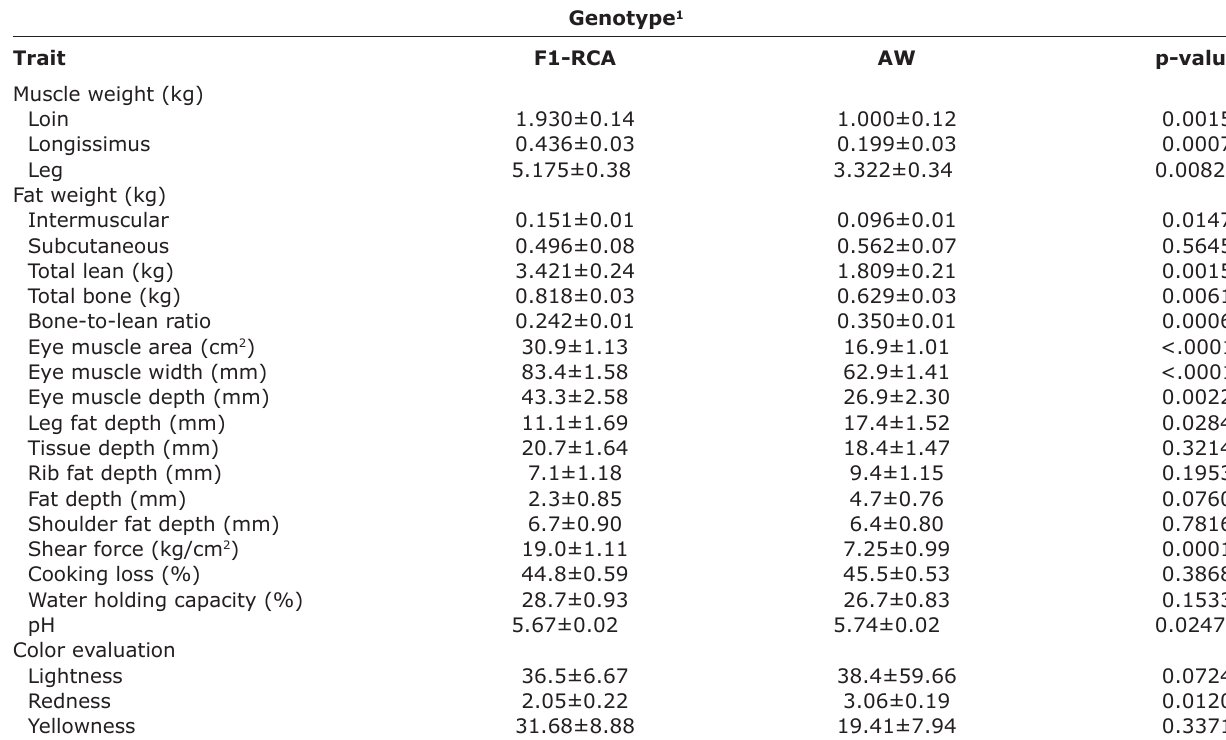
Table‑3: Effect of genotype (F1-RCA and pure AW) on dissected loin and leg cuts, carcass measurements, and meat quality